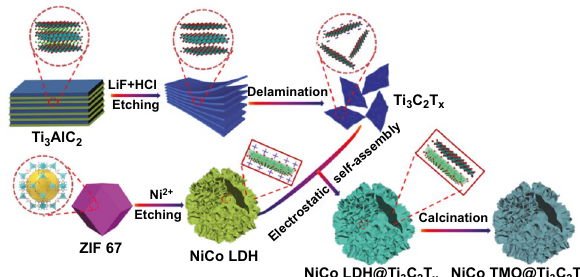
Fig. 1 Schematic diagram of synthetic process for LDHT and